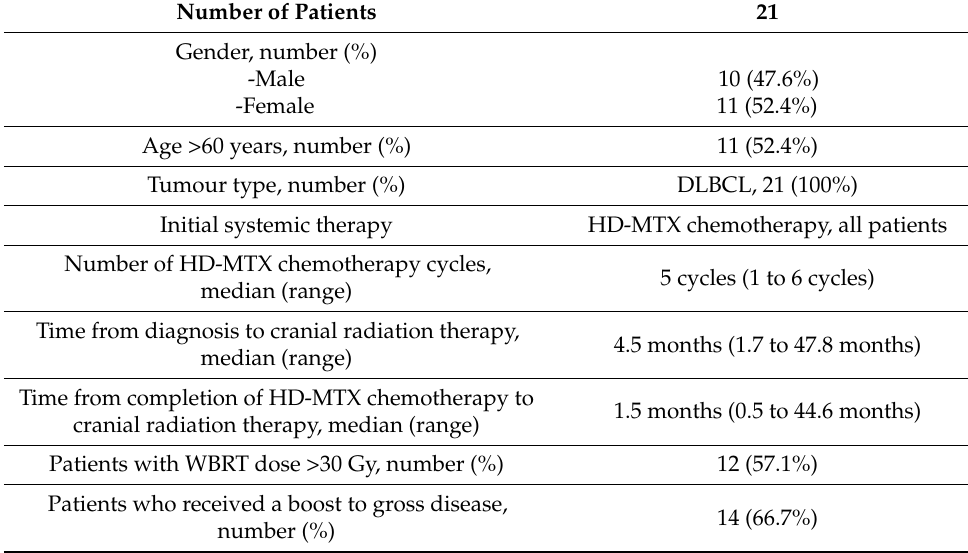
Table 1. Patient